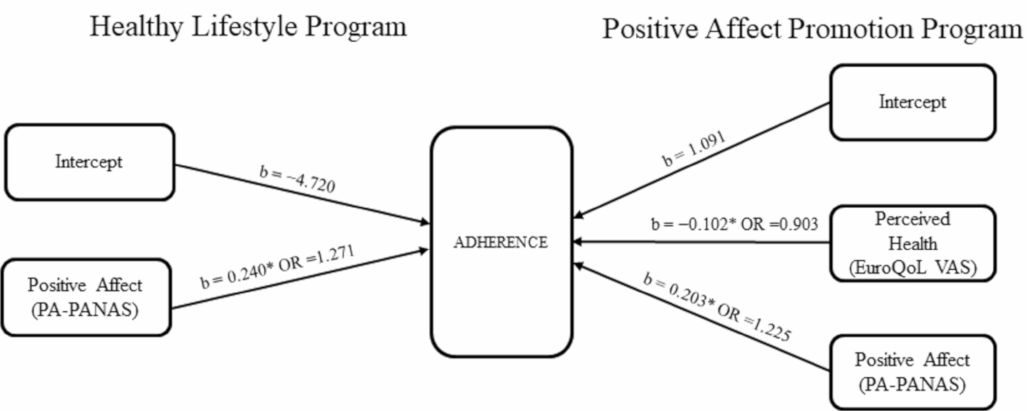
Figure 1. Regression models for Healthy Lifestyle program and Positive Affect Promotion Program. Notes: Healthy Lifestyle model: R 2 = 0.25 (Hosmer & Lemeshow), R 2 = 0.295 (Cox & Snell), R 2 = 0.394 (Nagelkerke). X 2 (1) = 16.11, p < 0.001; Positive Affect Promotion Model: R 2 = 0.29 (Hosmer &Lemeshow), R 2 = 0.336 (Cox & Snell), R 2 = 0.449 (Nagelkerke). X 2 (1) = 16.358, p < 0.001. b: Regression coefficient; OR: Odds ratio; * p < 0.05 (based on 95% bootstrap confidence intervals based in 1000